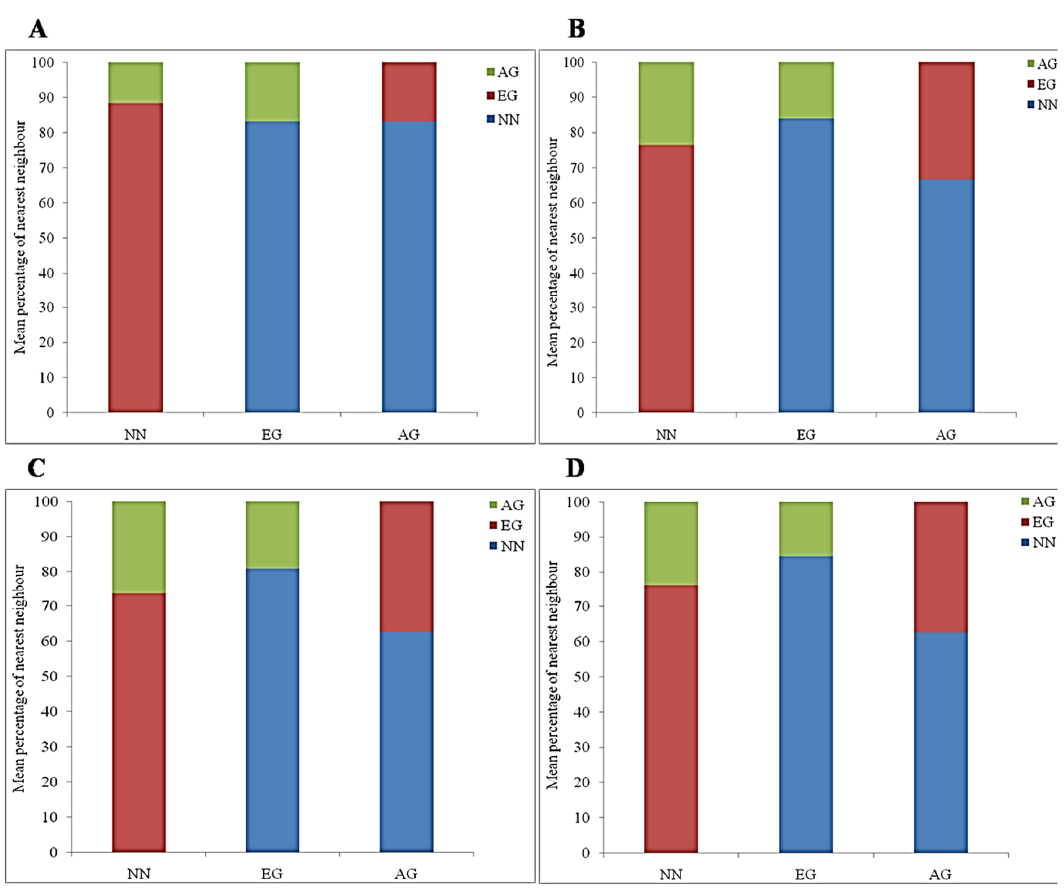
Figure 7. Histograms representing mean percentage of interspecific nearest neighbours of all three species NN= Nycticorax nycticorax , EG= Egretta garzetta , AG= Ardeola grayii . Nest number was documented in four plant species: Phoenix sylvestris , n=273; Azadirachta indica , n=134; Terminalia arjuna , n=85 and Tamarindus indica ,